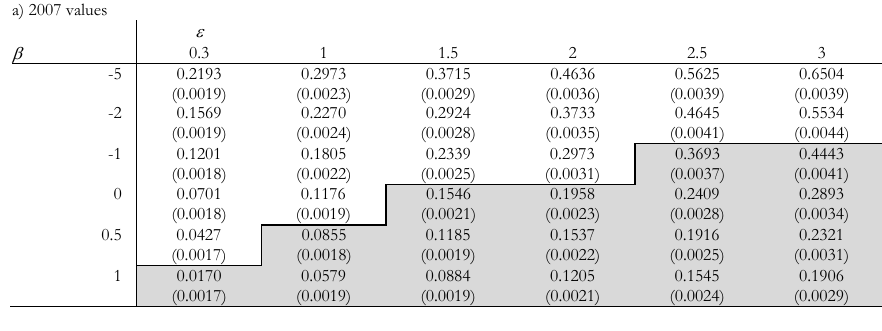
Multidimensional inequality measures: different  and  parameters